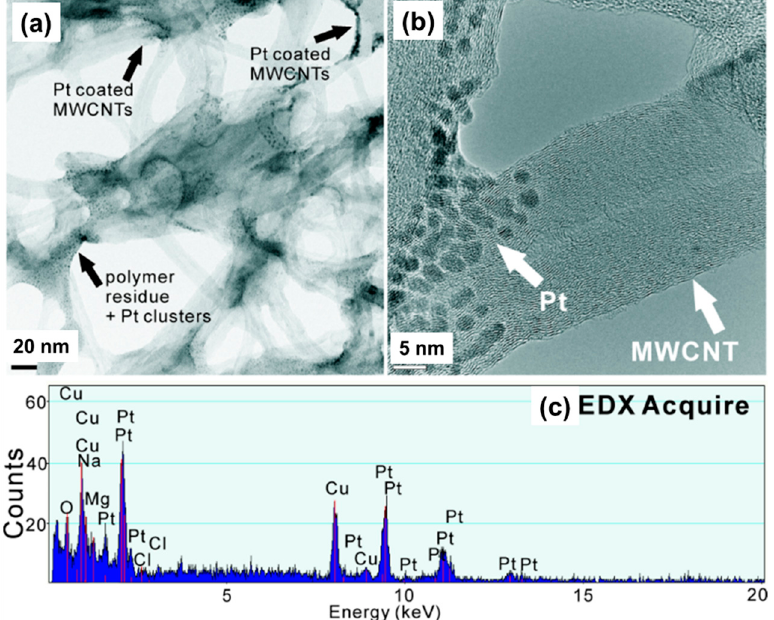
Figure 2. TEM image of overview of Pt coated MWCNTs (containing 30 wt% of Pt), containing Pt-coated MWCNTs and polymer residue with Pt clusters; ( a ) Overview TEM image of Pt coated MWCNTs; ( b ) TEM image of Pt coating on the surface of individual MWCNTs; ( c ) EDX analysis of selected area on the